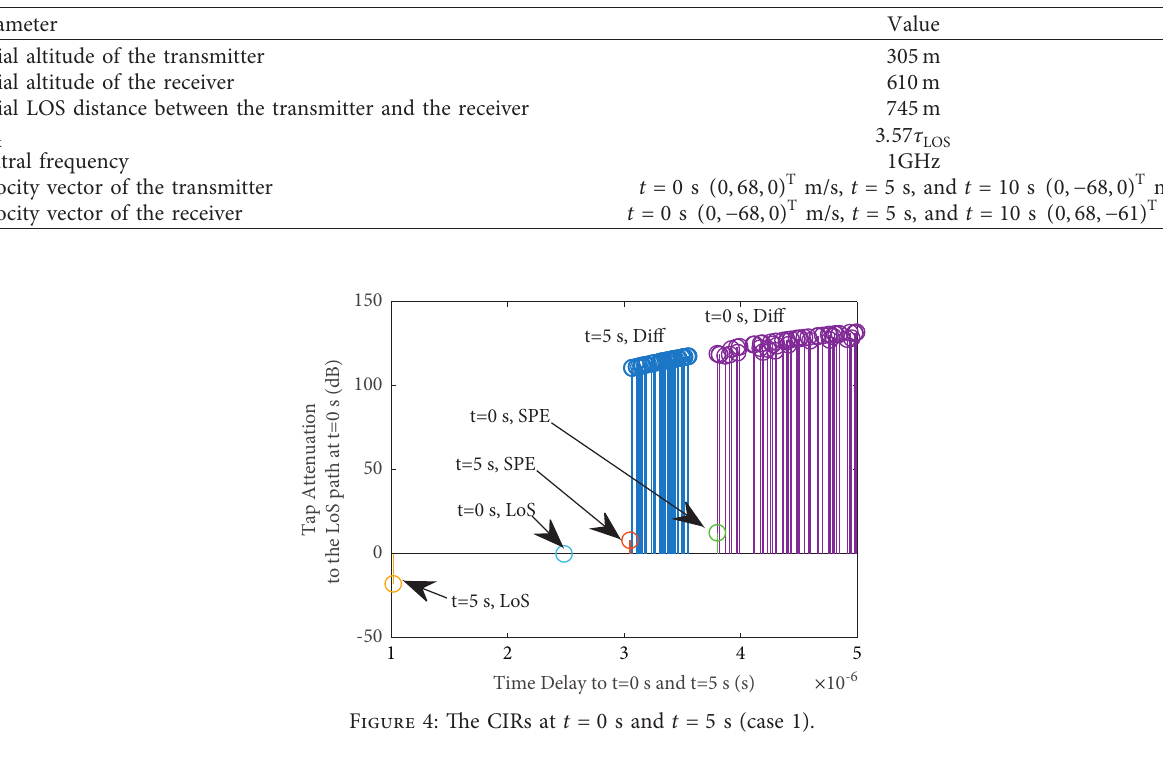
Table 2: Simulation parameters.